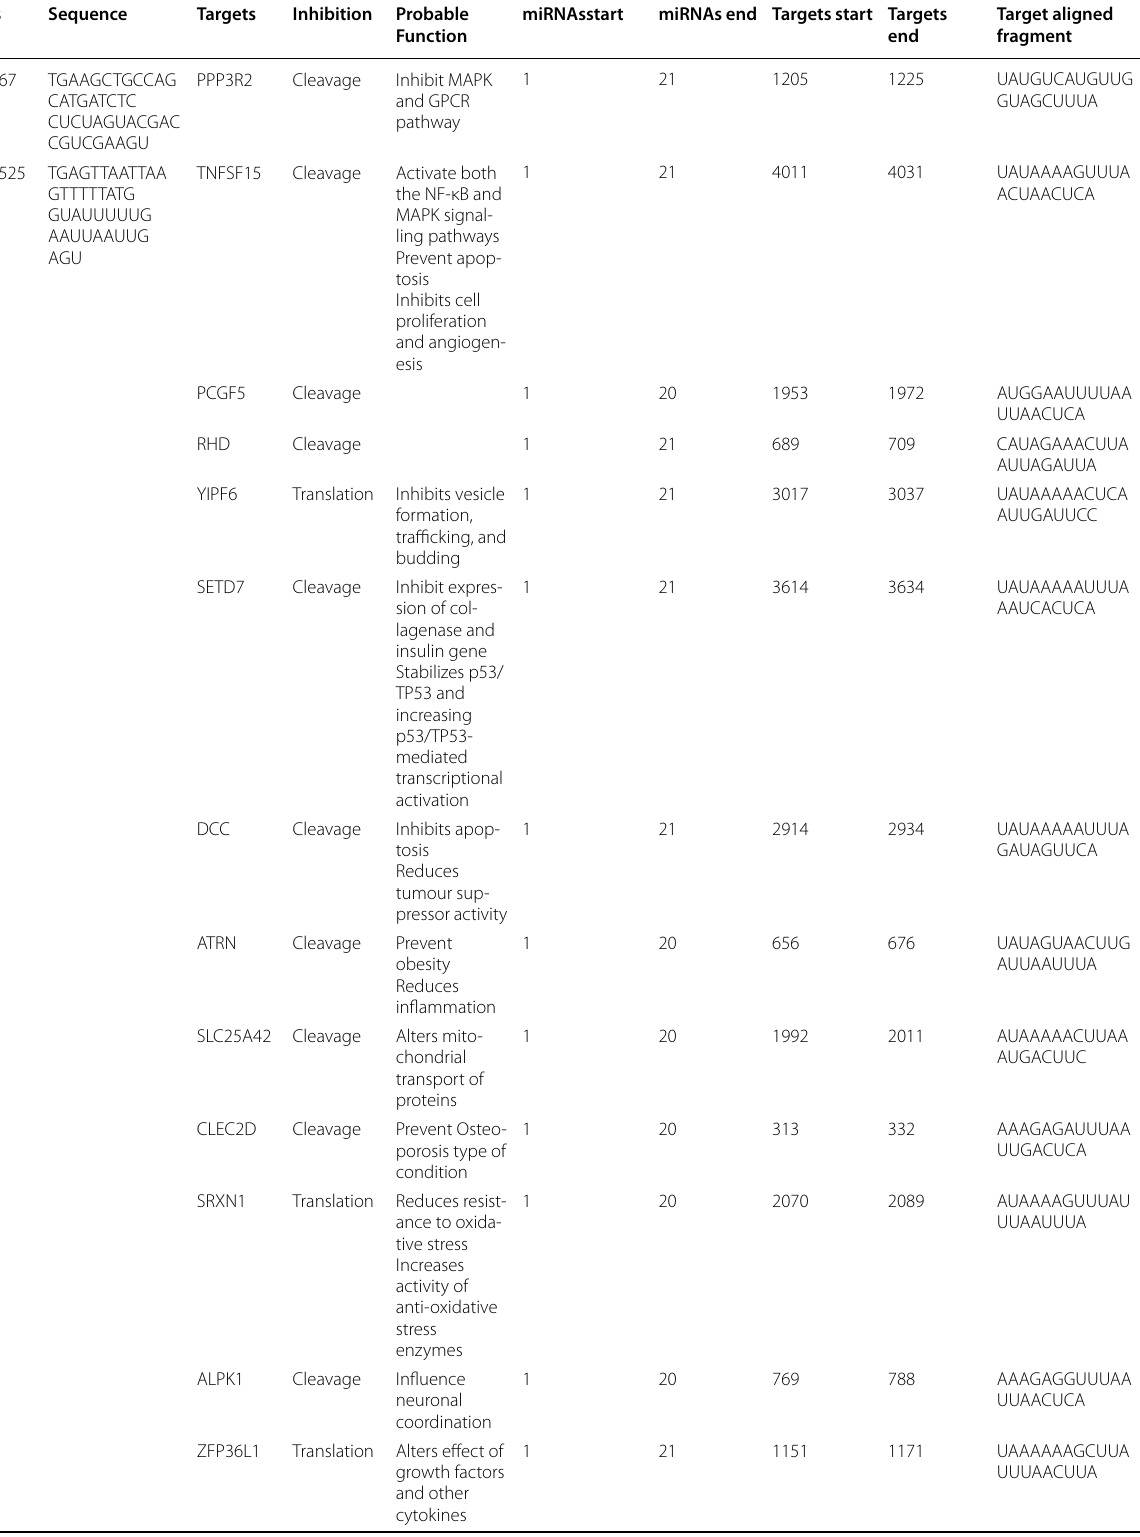
Table 2 The target prediction and accessibility of C. longa miRNAs using the psRNATarget in silico tool miRNAs Sequence Targets Inhibition Probable